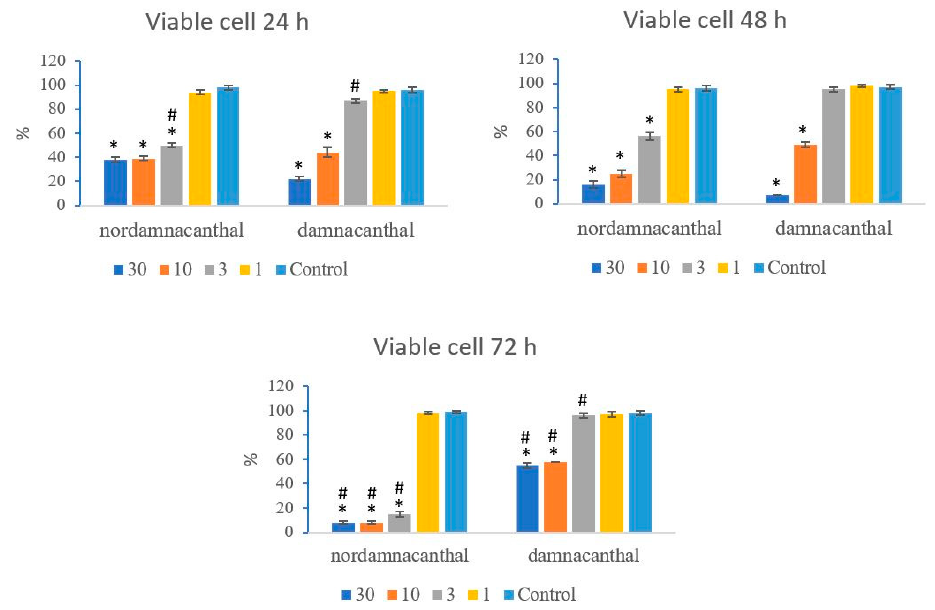
Figure 12. The percentages of viable CEM-SS cells treated with different concentrations of nordamnacanthal and damnacanthal at 24, 48, and 72 h. Control cultures were not treated with nordamnacanthal or damnacanthal. Each data point represents the mean ± SD. * Significant difference of p < 0.05 within the same anthraquinone group vs. its respective control. # Significant difference of p < 0.05 between nordamnacanthal and damnacanthal of the same concentration.